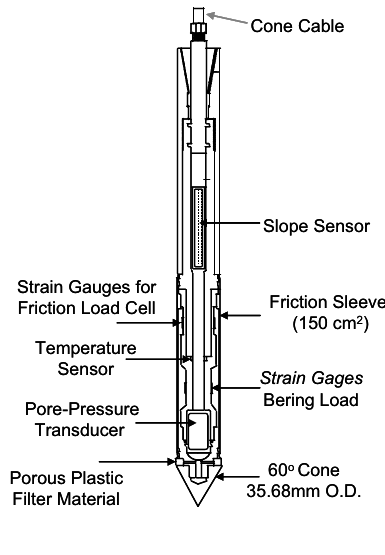
Fig. 2 – Schematic piezocone probe representation (Davies and Campanella